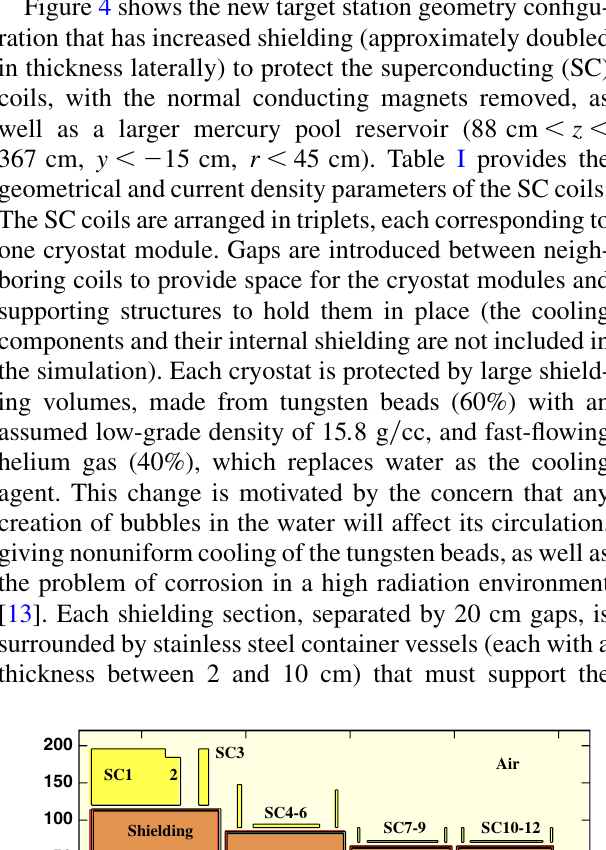
TABLE I. Parameters defining the superconducting (SC) coils for the new shielding geometry shown in Fig. 4: z position, (cid:1) z specifies the length along z , r (cid:1) r is the radial thickness, while I is the average current density. The last column specifies the coil materials used in the FLUKA simulation, where SCon is the compound Cu (54%), Nb (24%), Ti (12%), and kapton (10%). The mass densities for Nb SCon are 6 : 8 g = cc and 7 : 0 g = cc ,